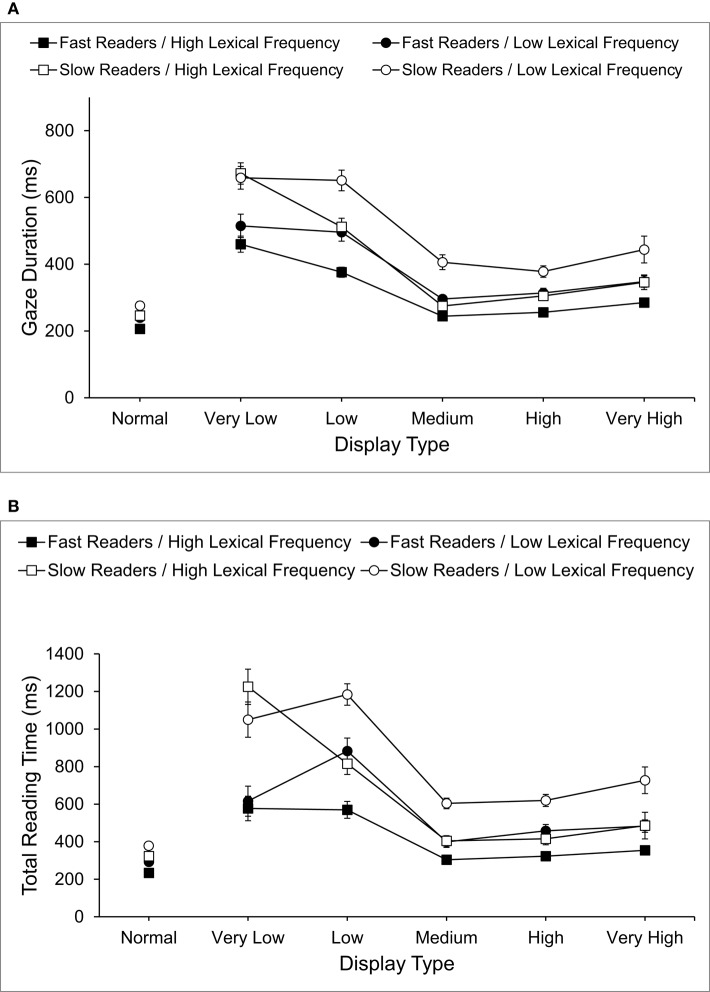
(A) Mean Gaze Durations and (B) mean Total Reading Times (including standard error bars) for fast and slow readers.